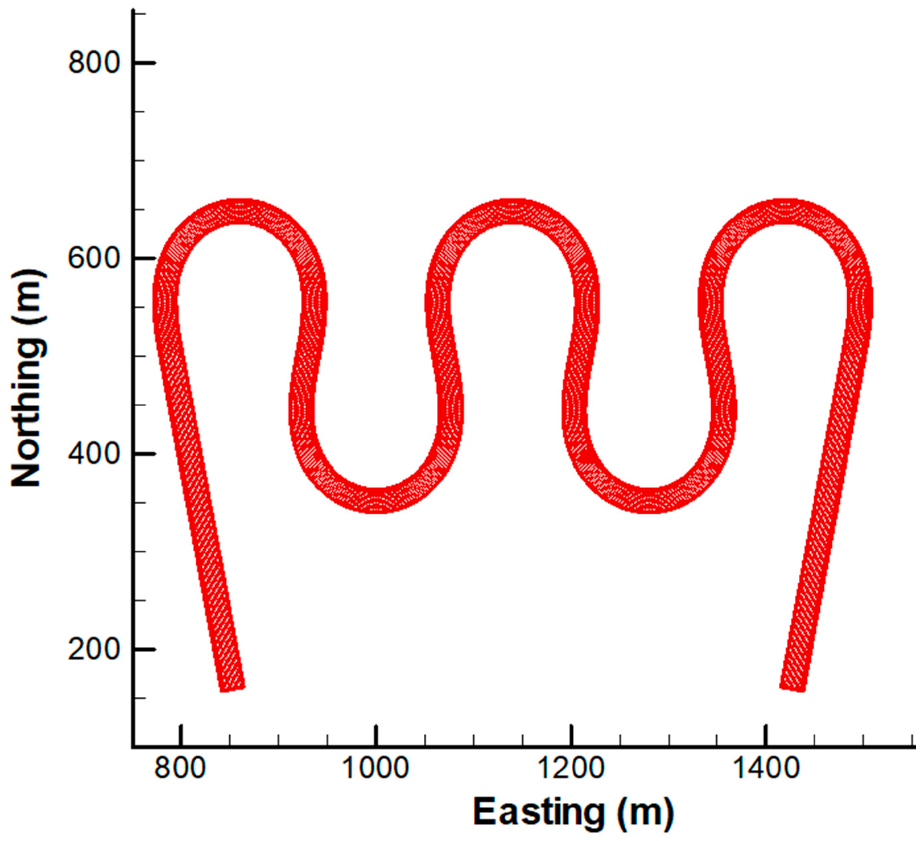
Figure 23. Plan view of the structured 2D model mesh domain for Simulation Set 5 with a sinuosity of 2.75.